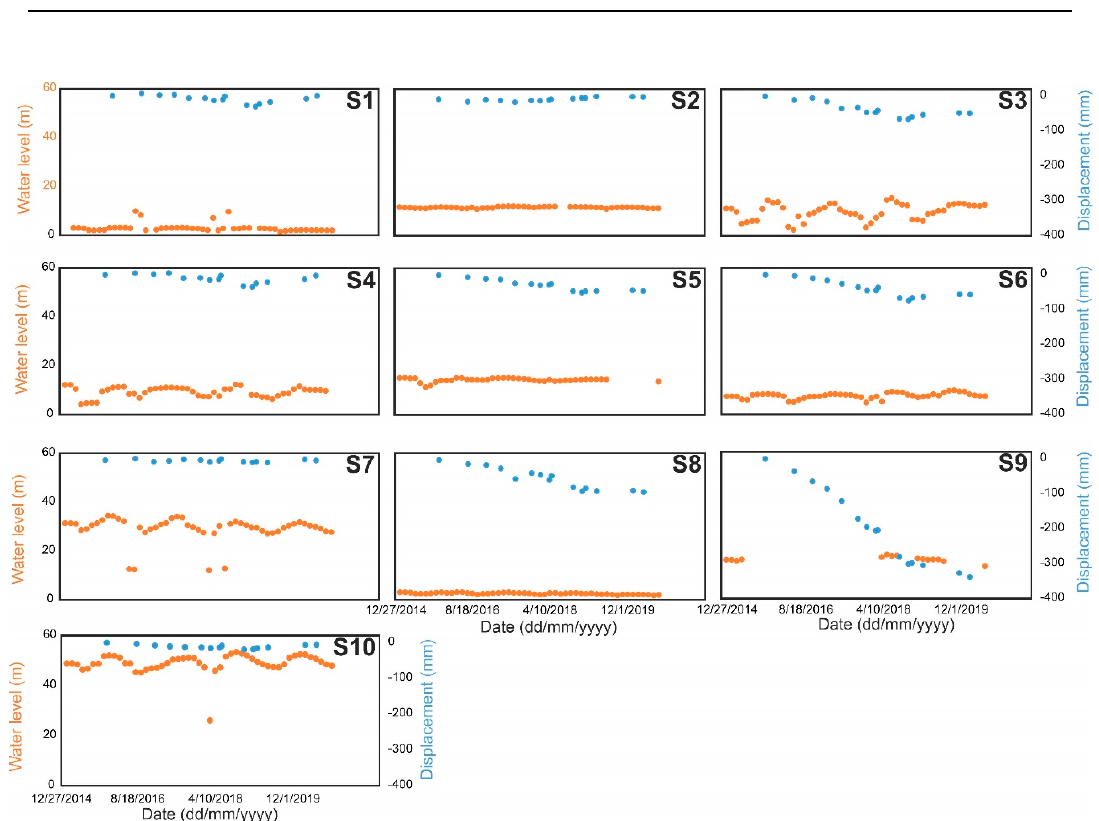
Figure 10. Vertical water changes versus vertical InSAR at 10 locations. Locations of wells are shown in Figures 1c and 7a.